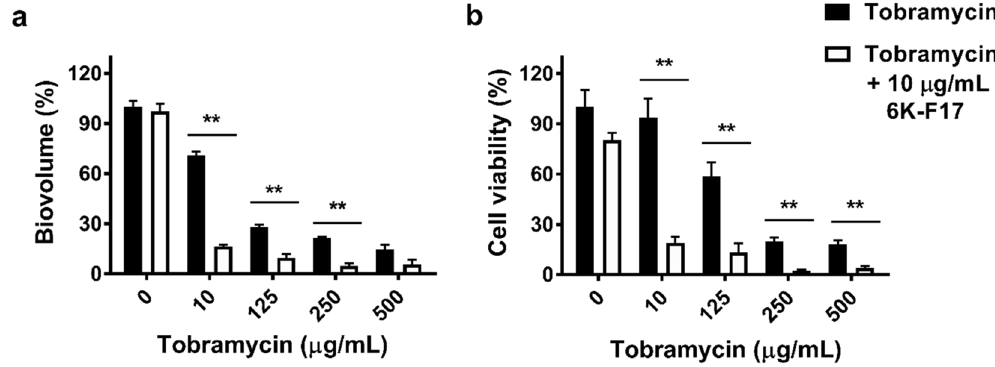
Figure 3. Cationic peptide 6K-F17 potentiates tobramycin activity against P. aeruginosa biofilms. 30-hour slide chamber P. aeruginosa PAO1 biofilms were grown with tobramycin alone in increasing concentrations, or with a fixed concentration (10 µ g/mL) of 6K-F17 + increasing concentrations of tobramycin for 16 hours prior